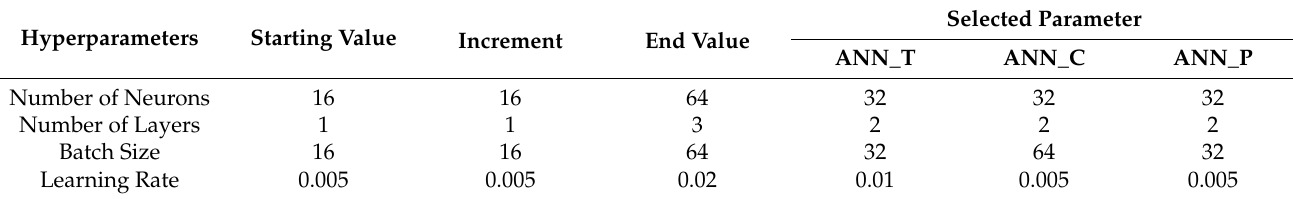
Table 7. Selection of hyperparameters for ANN model for all endpoints.